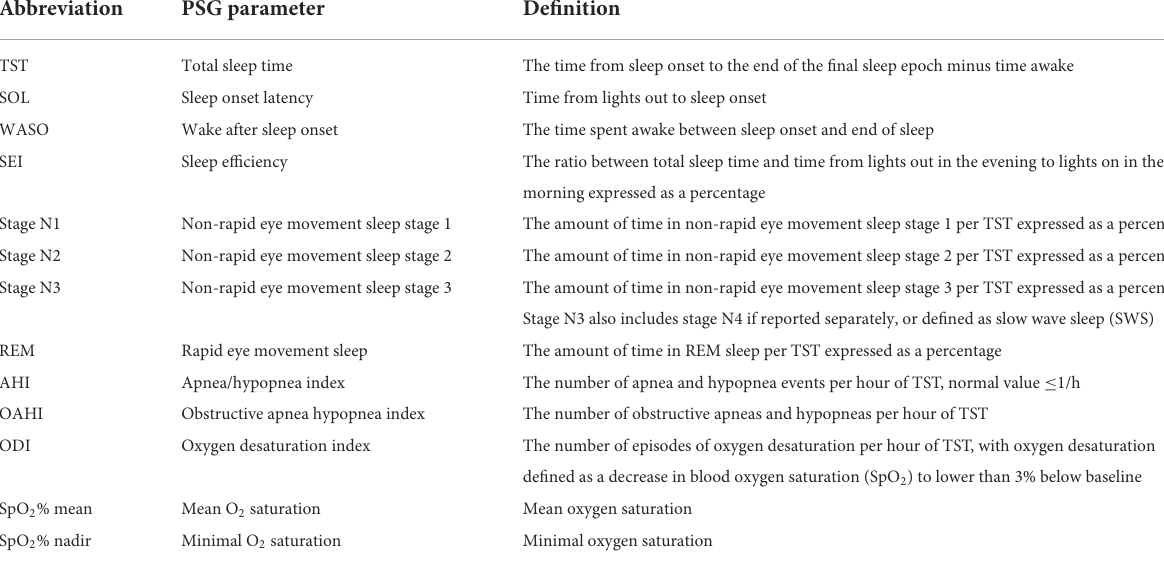
TABLE 1 PSG parameters and their definition in this